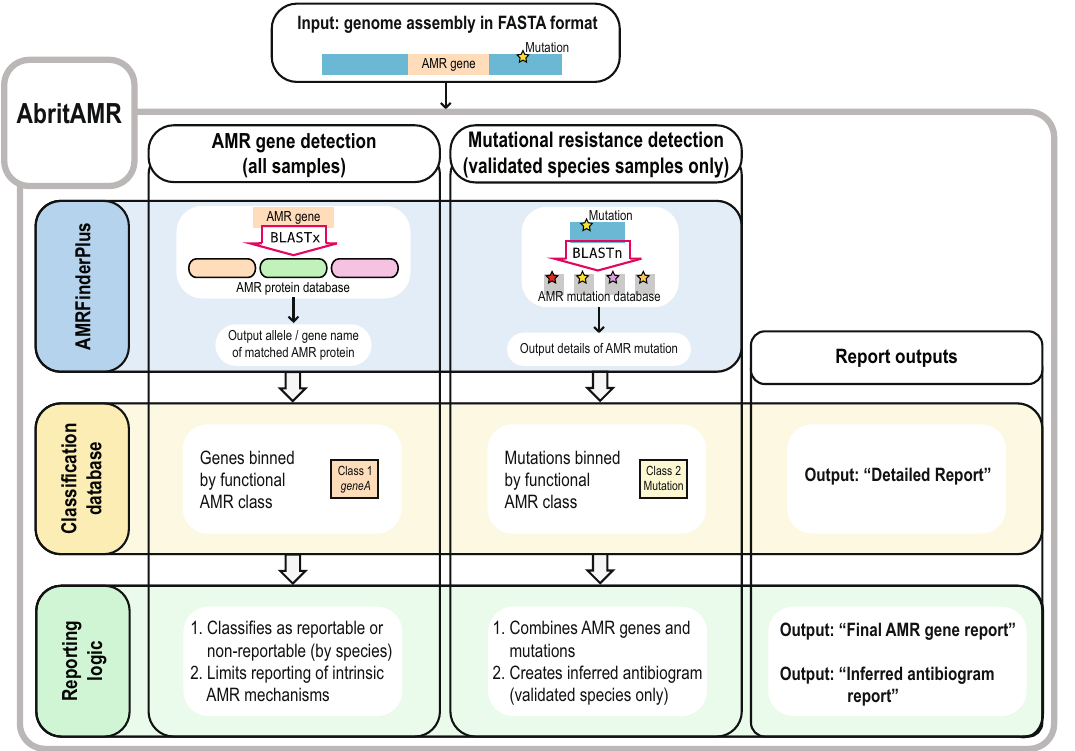
Fig. 1 | Overview of abritAMR pipeline. Assembled bacterial genomic sequence data (short- or long-read or hybrid assemblies, fasta format) are inputted in to the abritAMR pipeline to identify acquired AMR genes and mutations. The pipeline implements the AMRFinderPlus tool, identifying AMR genes (BLASTx search), and optionally identi fi es mutations associated with AMR for speci fi ed species where mutationaldataareavailable.Identi fi ed AMRgenes+/ − mutationsarethenbinned into functional AMR classes according to the classi fi cation database